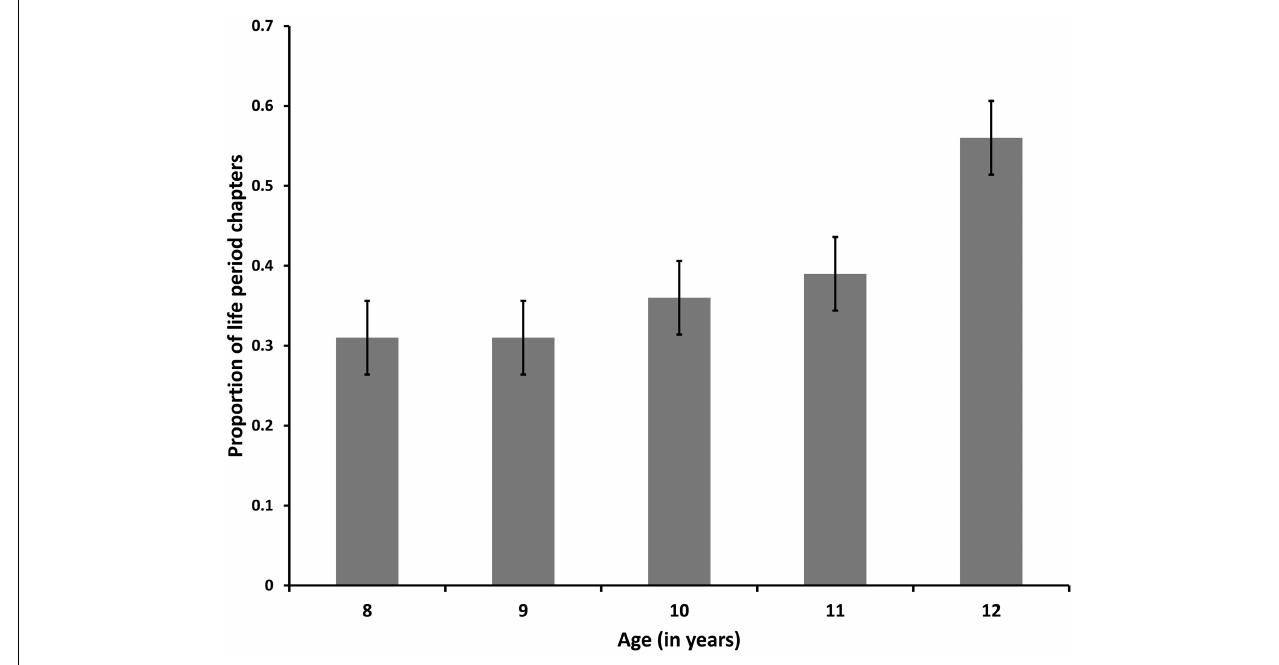
FIGURE 1 | Proportions of lifetime-period chapters across age groups (Study 1)